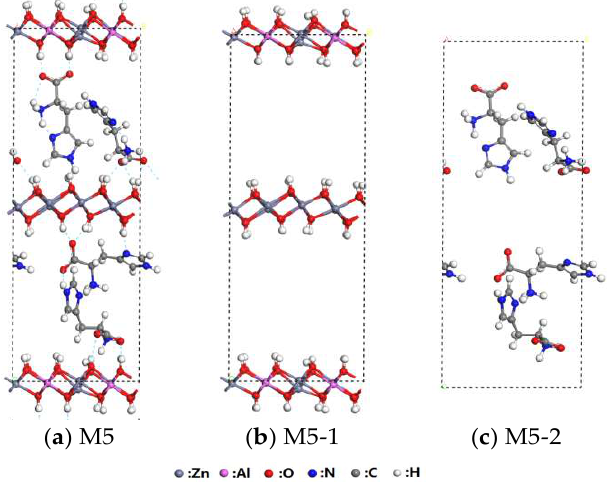
Figure 3. Structural models of histidine intercalated LDHs; ( a ): histidine-intercalated LDHs structure; ( b ): LDHs lamellas structure; ( c ): histidines structure in M5.